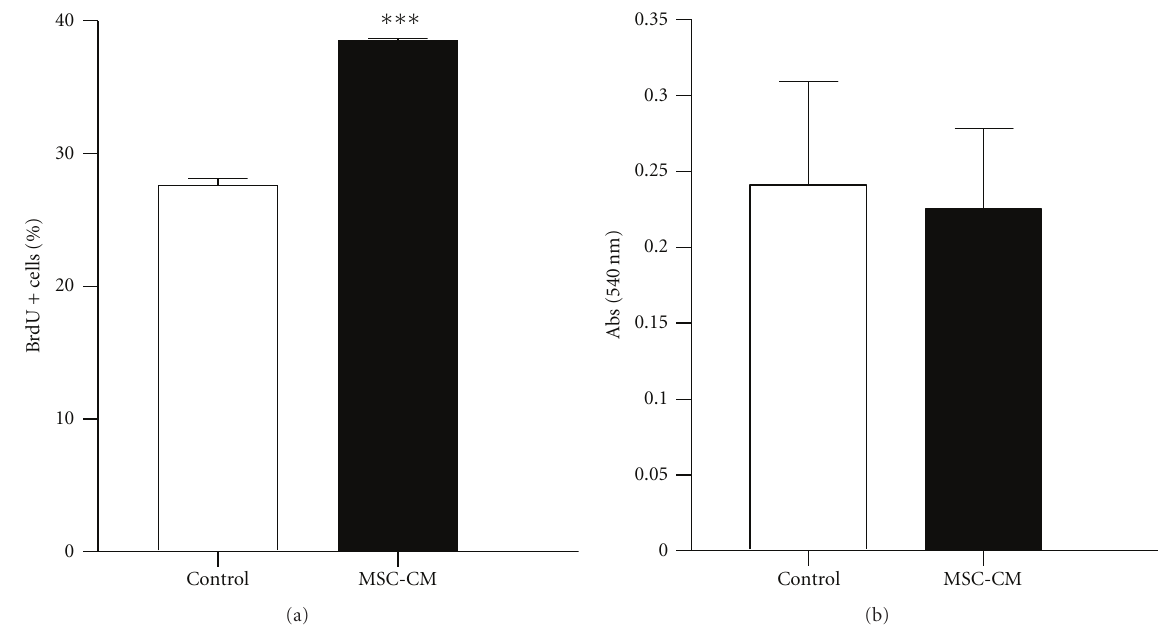
Figure 4: MSC secreted factors stimulate adult NSC proliferation. (a) Survival of NSC measured by MTT assay. (b) Proliferation of NSC measured by BrdU incorporation using flow cytometry. Data are mean ± SEM of two independent experiments performed in triplicates. ∗∗∗ P < . 001.